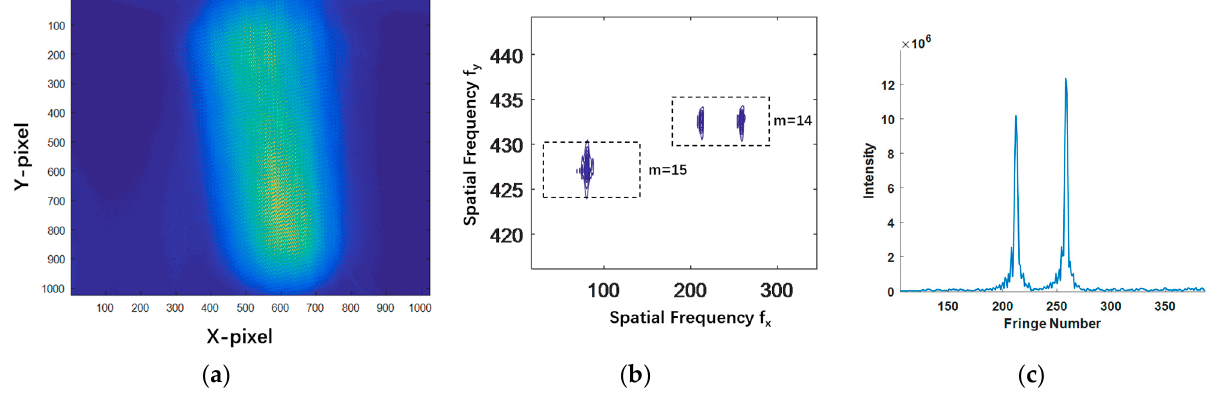
Figure 2. ( a ) Interferogram of the mercury lamp; ( b ) mercury lamp level chart; ( c ) spectral spatial frequency of the mercury lamp.